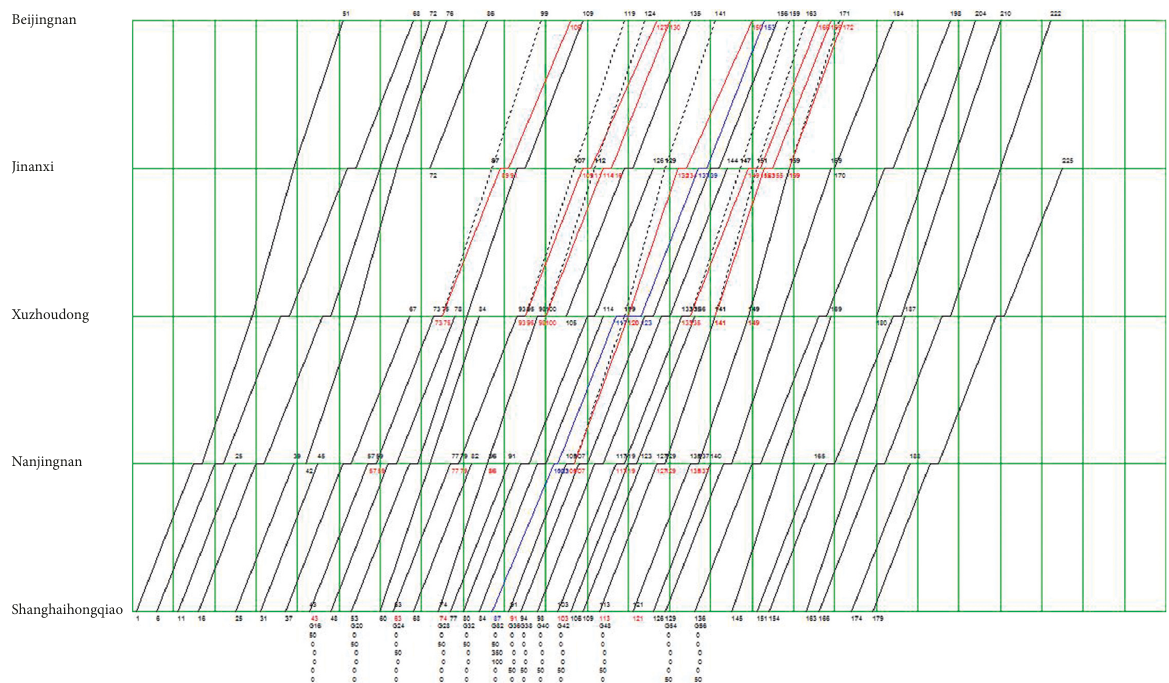
Figure 6: The optimal rescheduling operation plan in the